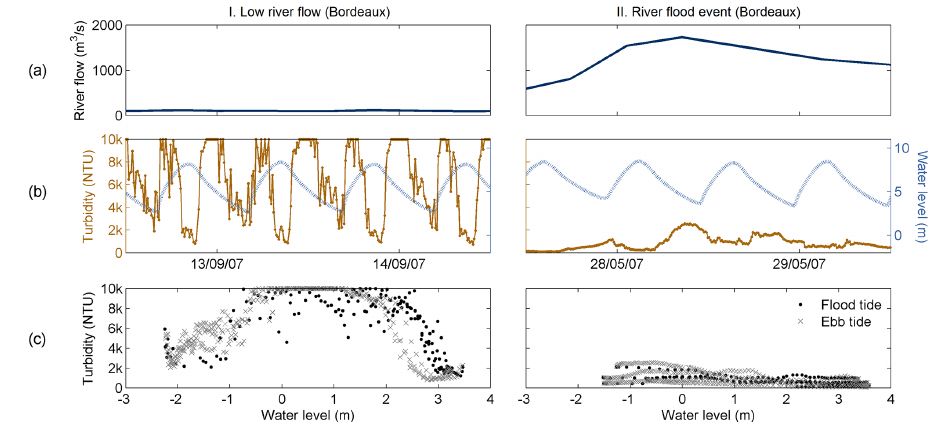
Figure 4. Examples of 48h raw data of (a) river flow, and (b) turbidity and water level (dotted lines) at Bordeaux for two contrasted hydrological conditions. The mean time step of river flow is 1h, while turbidity and water level were recorded every 10min. (c) Relationships between turbidity and water level records of the middle panels.